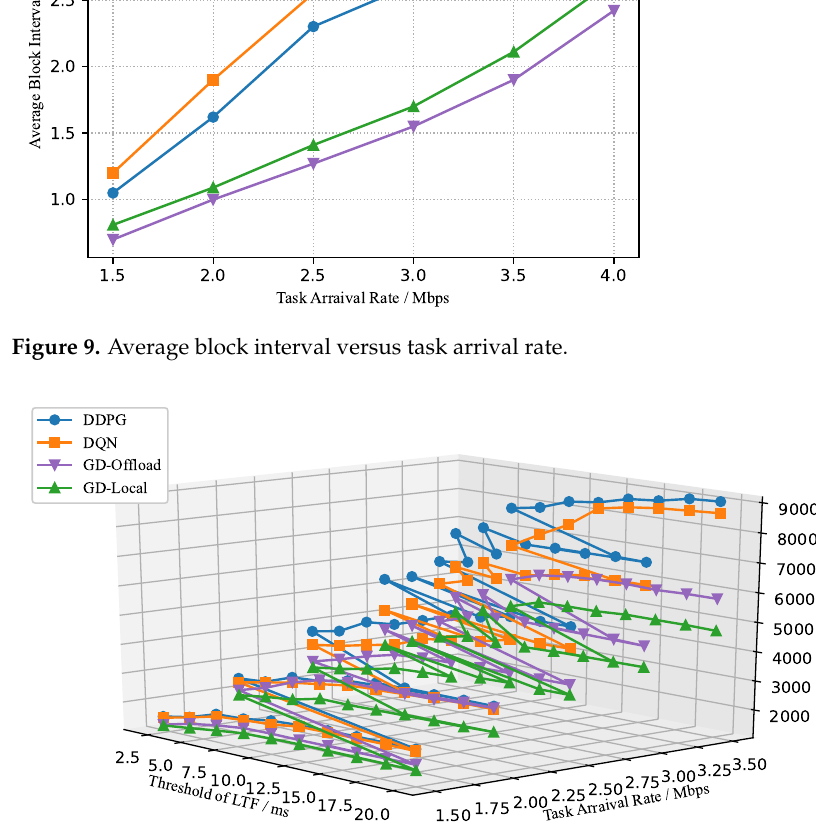
Figure 10. Average reward versus threshold of LTF and task arrival rate.